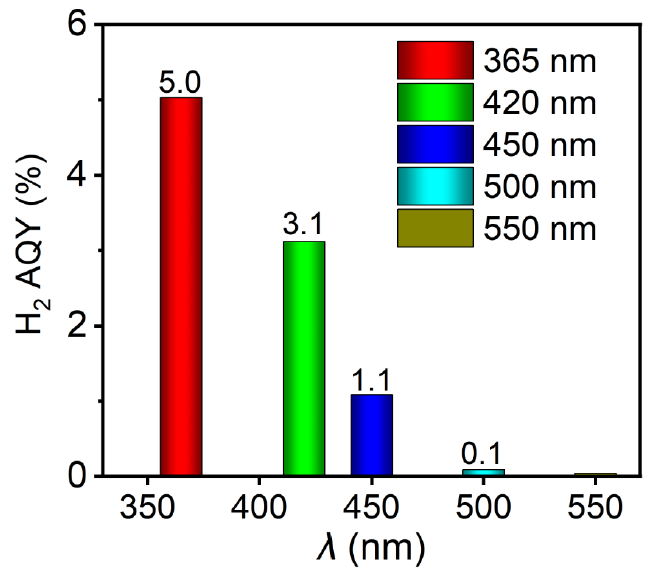
Figure 9. Wavelength-dependent AQYs of photocatalytic H 2 production and the corresponding UV-vis DRS spectrum for 10% BP/KPHI. UV-vis DRS spectrum for 10%